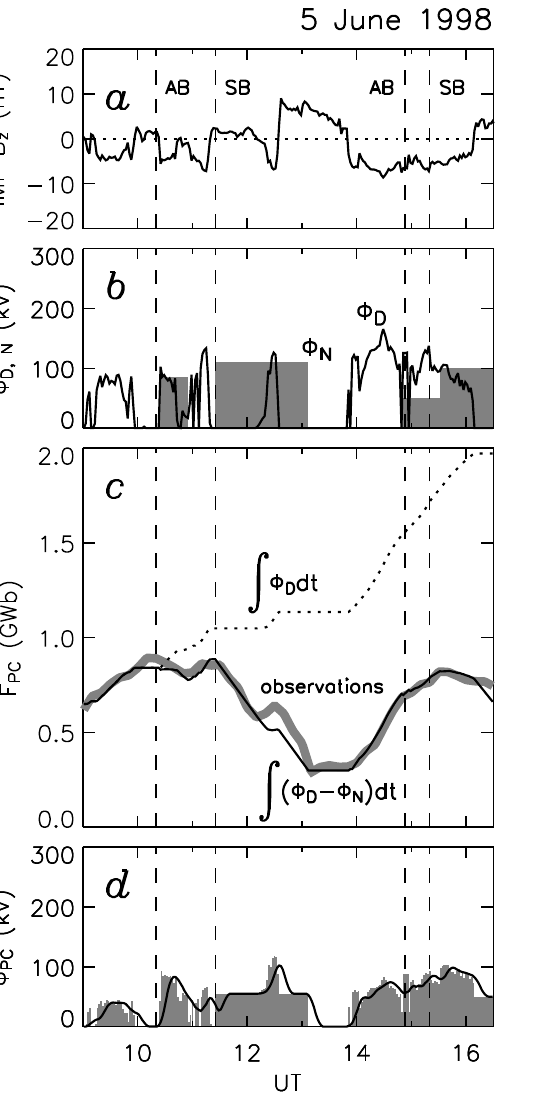
Fig. 1. Observations of changes in polar cap flux and deduced rates of dayside and nightside reconnection for two 8-hour intervals on 5 June and 26 August 1998. ( a , e ) IMF B z lagged to the magnetopause. ( b , f ) Deduced rates of day- (solid curve) and nightside (grey blocks) reconnection. ( c , g ) Variation in polar cap flux (grey curve), modeled polar cap flux derived from integration of dayside reconnection rate (dotted curve) and modeled polar cap flux including fitted nightside reconnection (solid curve). ( d , h ) Cross polar cap potential derived from day- and nightside reconnection rates (grey), and smoothed with a triangular response function (solid